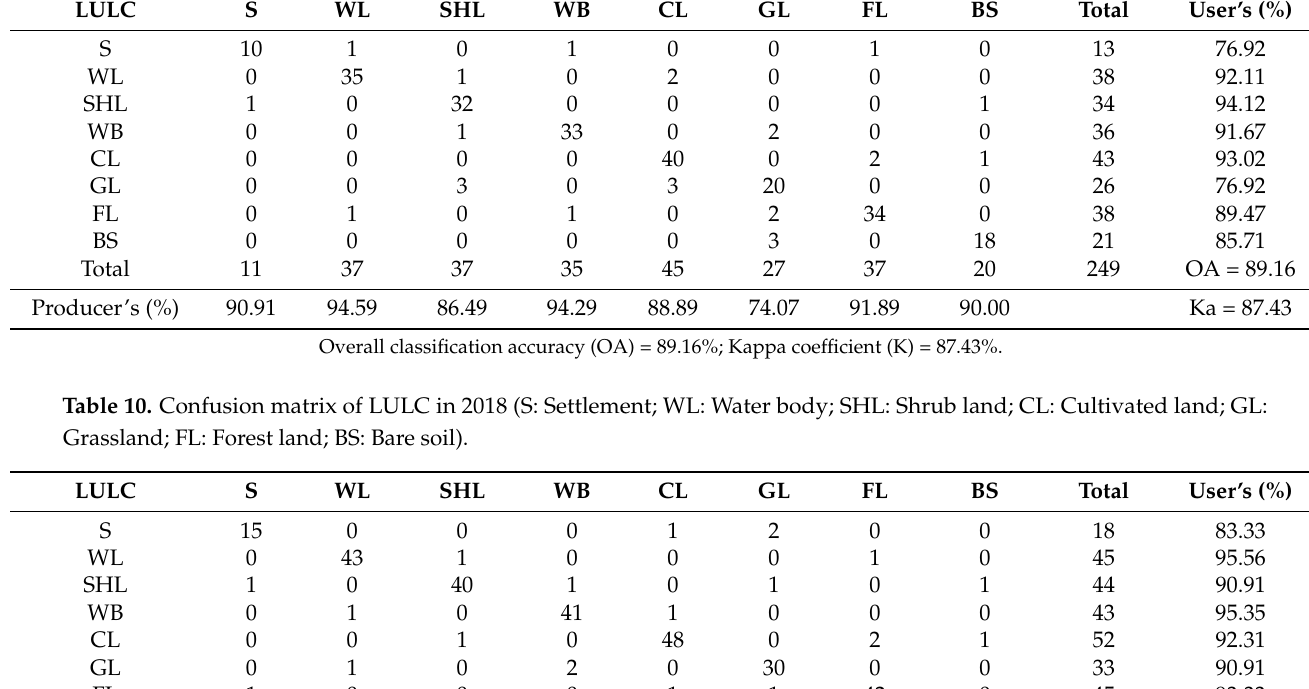
Table 9. Confusion matrix of LULC in 2004 (S: Settlement; WL: Water body; SHL: Shrub land; CL: Cultivated land; GL: Grassland; FL: Forest land; BS: Bare soil).